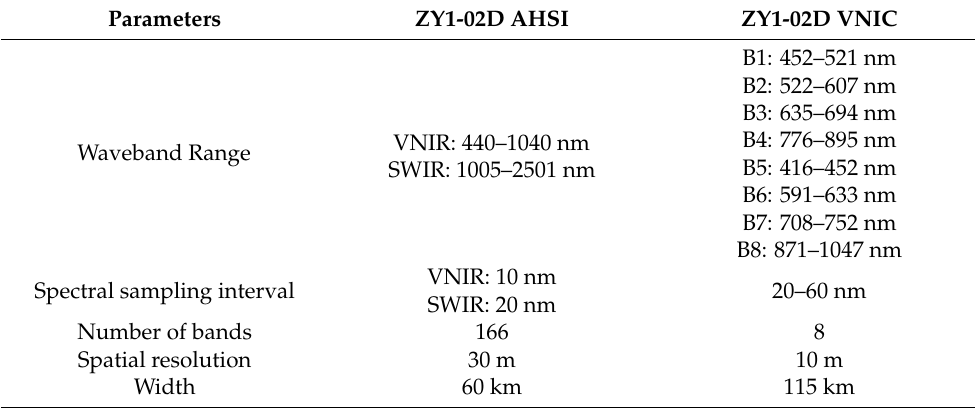
Table 1. ZY1-02D parameter